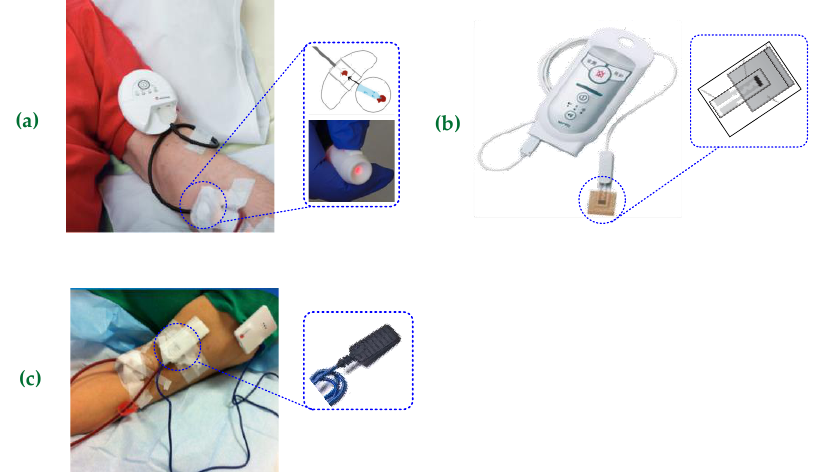
Figure 2. ( a ) Redsense ® Monitor (light sensor); ( b ) HEMOdialert™ (moisture sensor); ( c ) Nipro moisture sensor.